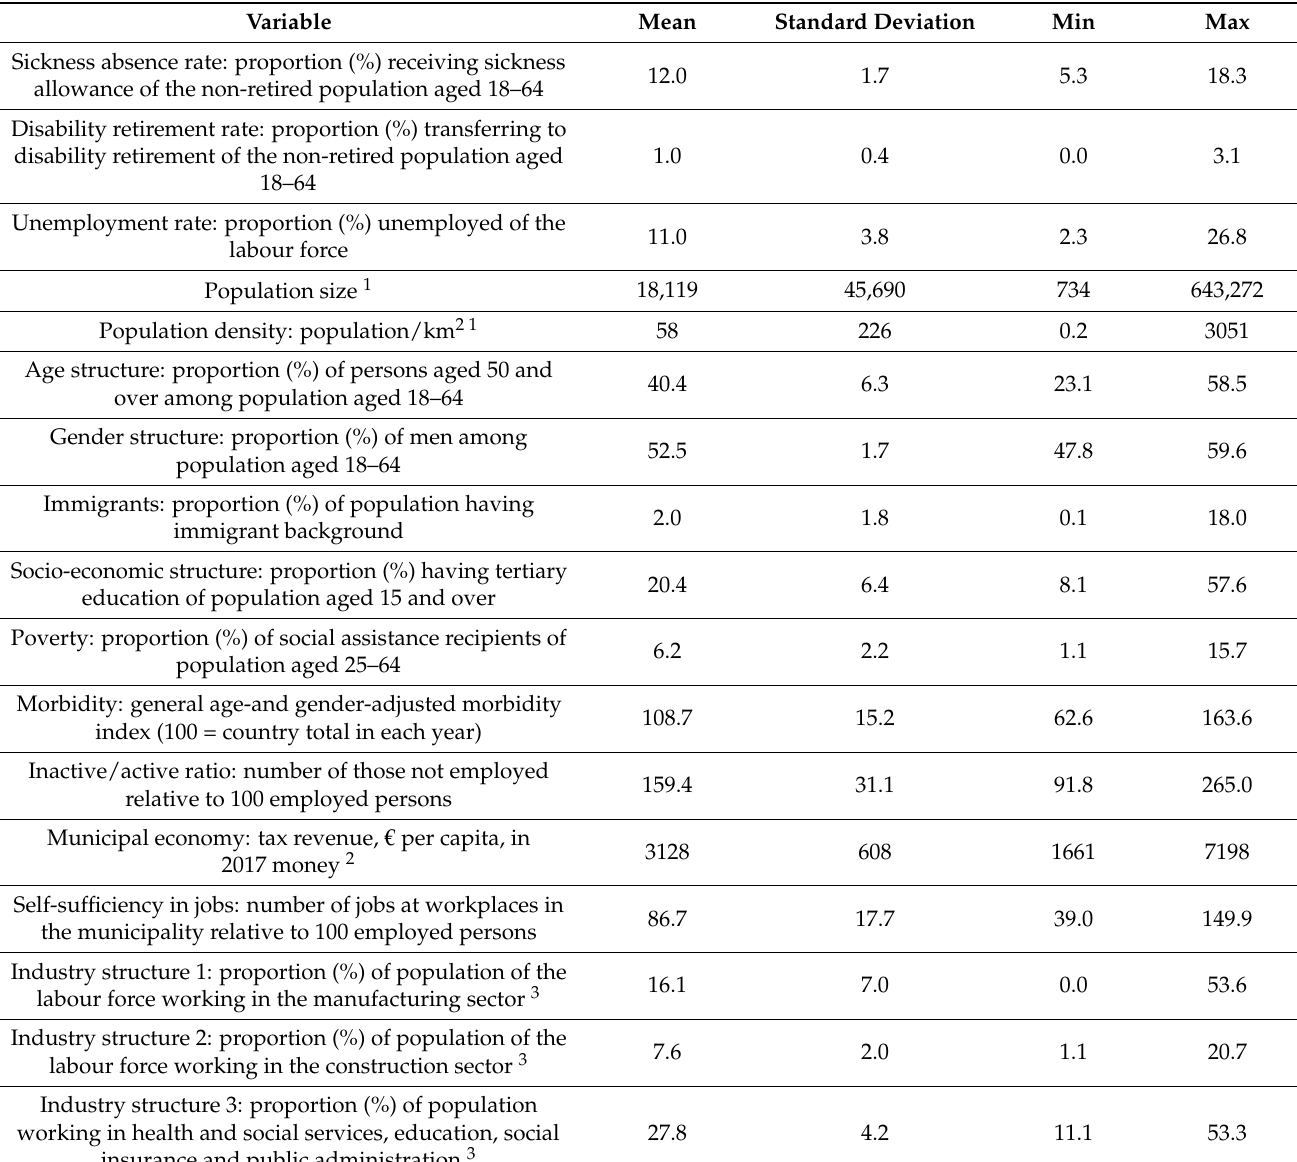
Table 1. Descriptive statistics for the municipality-level variables, measured yearly in 2003–2017. All municipalities ( n = 295) and years ( n = 15) pooled, total n = 4425